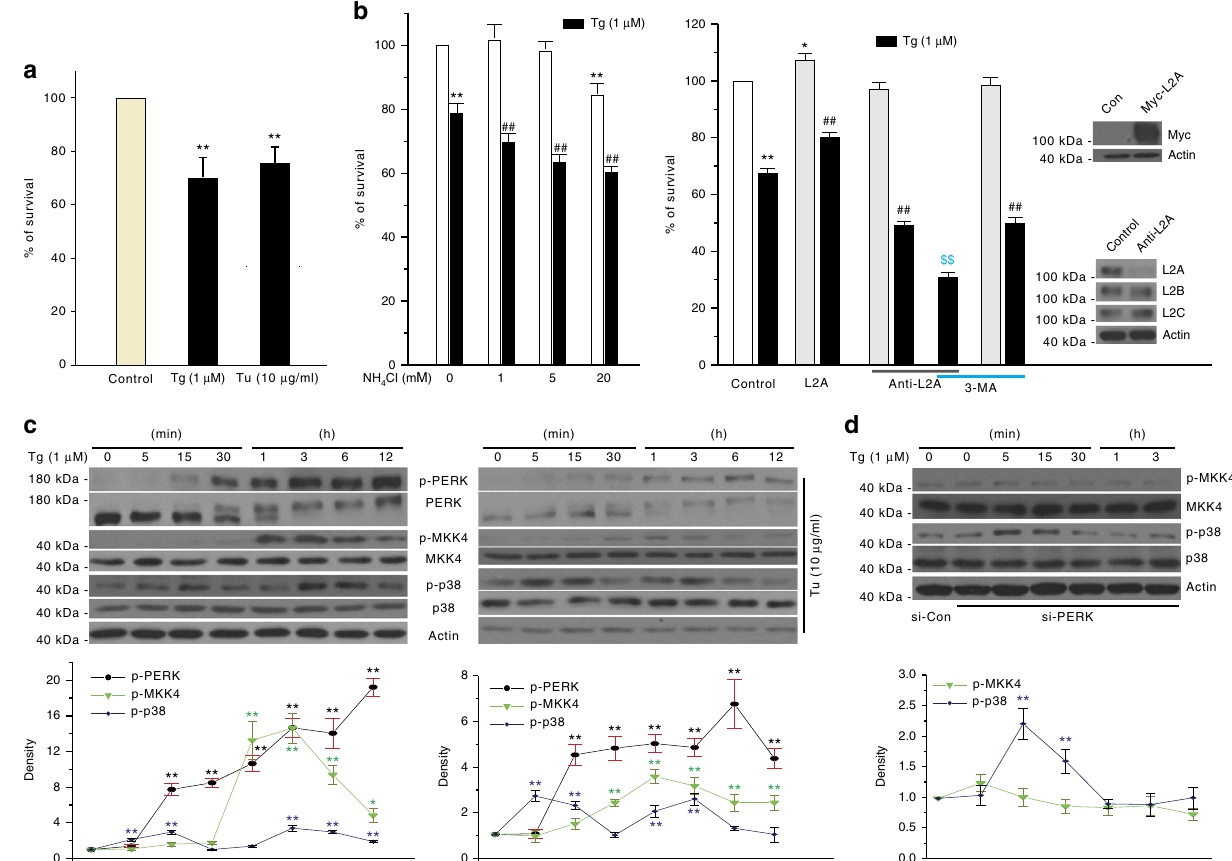
Fig. 6 ER stress-induced CMA is cellular protective. a ER stress induces cell death. SN4741 cells were exposed to Tg or Tu for 24 h. Cell viability was measured by MTT assay. b Blocking lysosomal function aggravates ER stress-induced cell death. SN4741 cells were treated with Tg with or without NH 4 Cl at indicated concentrations for 24 h (left panel). After 24 h transfection of HA-LAMP2A (L2A) or 48 h anti-sense LAMP2A (Anti-L2A), SN4741 cells were treated with Tg alone or with 3-MA (5 mM) for 24 h. Cell viability was measured by MTT assay. Inlet shows the levels of LAMP2A overexpression or knockdown and the levels of LAMP2B and LAMP2C. Values in a and b are mean ± s.e.m, ( n = 3 × 4 replicates of independent experiments (ANOVA with Turkey test); * p < 0.05 or ** p < 0.005 vs. control, ## p < 0.05 vs. Tg alone group, $$ p < 0.005 vs. anti-L2A with Tg group). c ER stress induces a biphasic activation of p38 MAPK. SN4741 cells were treated with Tg or Tu at indicated time periods. Total proteins were blotted as indicated. d Knockdown of PERK speci fi cally blocks the second wave of p38 MAPK activation. SN4741 cells transfected with control and si-PERK were treated with Tg for various periods of time. Quanti fi cations are shown at c and d bottom panels (Values are mean ± s.d. n = 3 (ANOVA with Turkey test); ** p < 0.005 vs.